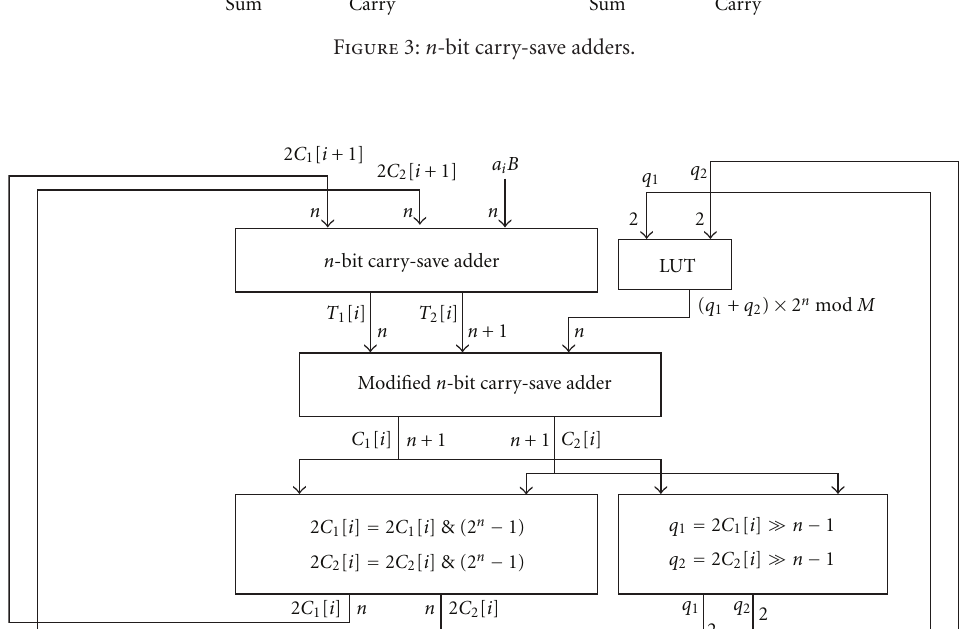
Figure 4: New sum of residues modular multiplier